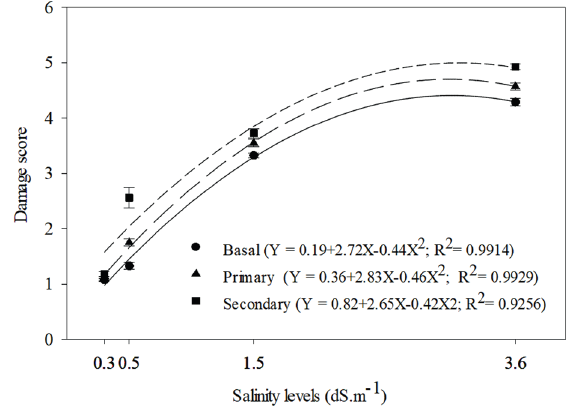
Figure 5 - Damage score of cactus pear cv. Miúda according to the salinity levels and cladode order (basal: line solid; primary: line long dash and secondary: line short dash). Error bars represent the standard error of the mean.